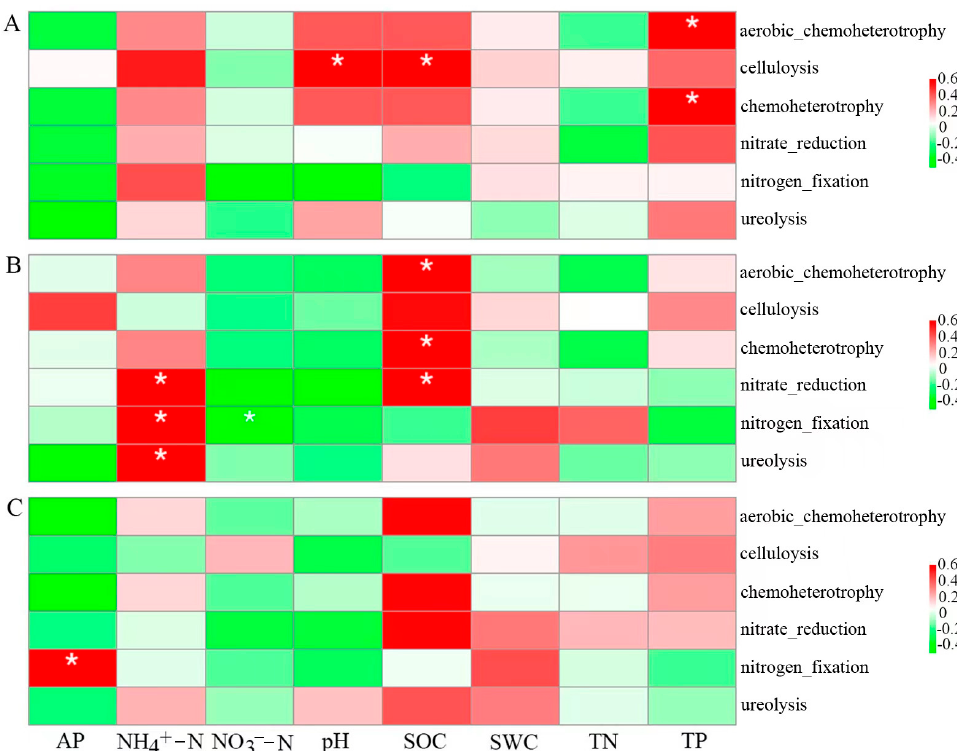
Figure 7. Correlation between the six dominant bacterial functional groups and soil physicochemical properties in topsoil ( A ), middle layer ( B ), and subsoil ( C ). * p < 0.05. SWC: soil water content; SOC: soil organic carbon; TN: total nitrogen; NH 4+ -N: ammoniacal nitrogen; NO 3 − -N: nitrate nitrogen; TP: total phosphorus; AP: available